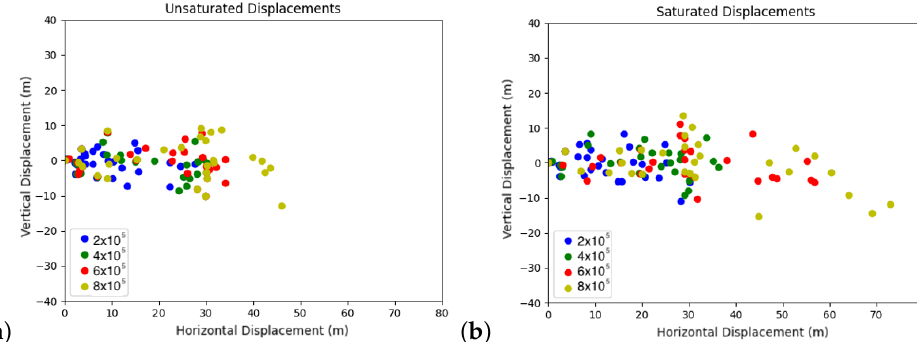
Figure 4. Plots of the displacement (shown in meters) of the streamlines sampled at times 2 × 10 5 , 4 × 10 5 , 6 × 10 5 and 8 × 10 5 seconds for: ( a ) Unsaturated conditions and ( b ) Saturated conditions. There is a higher dispersivity coefficient, α , in the horizontal ( x ) direction than the vertical as shown by the values calculated in Table 1. This is expected as there is no pressure difference in the vertical axis to force fluid flow, and longitudinal dispersivity is typically greater than transverse dispersivity. However, it should be noted that the vertical dispersivity decreases under saturated conditions, while the horizontal dispersivity tends to increase. This is due to the significantly higher horizontal dispersivity so the horizontal fractures expand more than the vertical. Thus, permitting greater transport in the horizontal direction than the